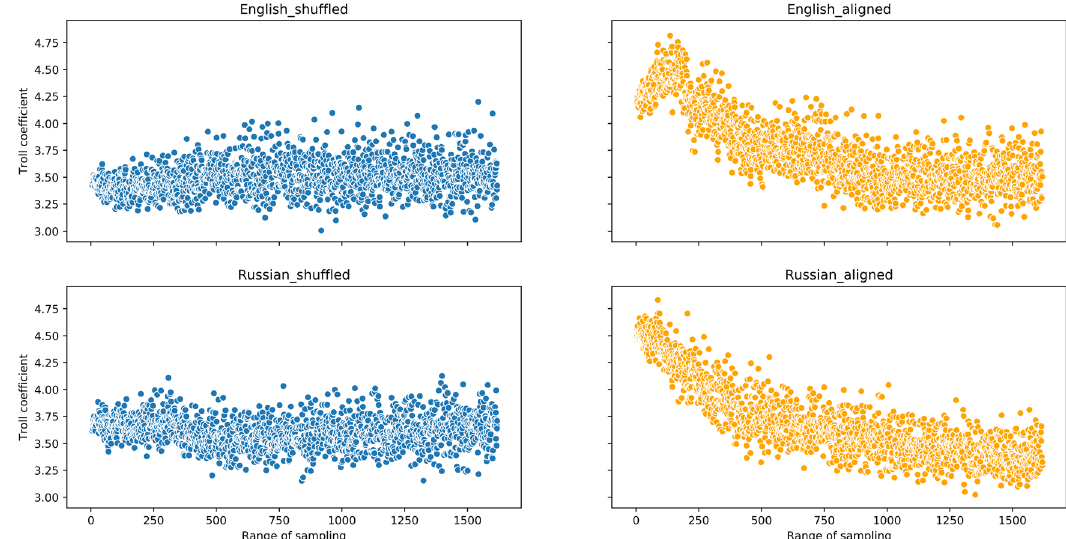
Fig. 1 Distribution of troll coef fi cients. Patterns observed in randomly shuf fl ed and chronologically aligned English and Russian reviews.